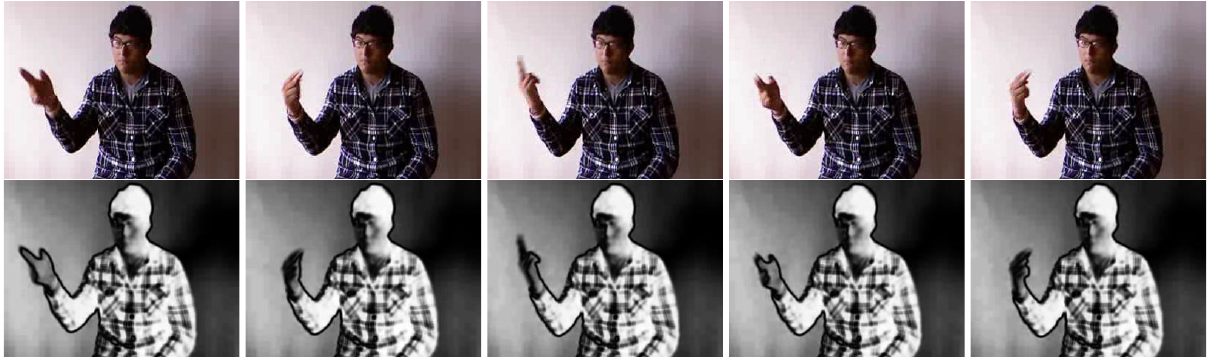
Figure 2. Illustration of a RGB sequence ( top ) and its saliency sequence ( bottom